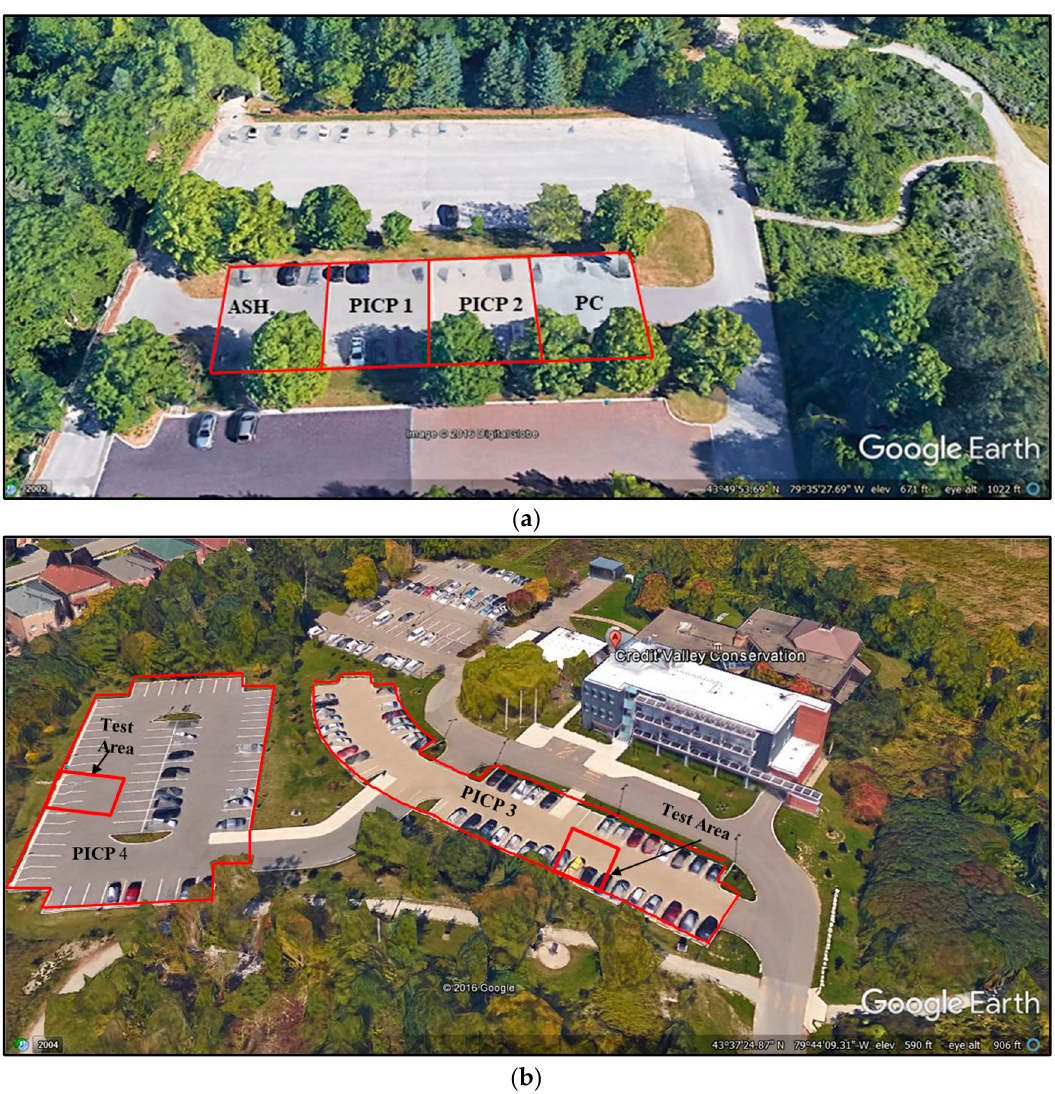
Figure 1. Field Sites ( a ) Parking lot at Toronto and Region Conservation Authority (TRCA), Vaughan ( b ) Credit Valley Conservation (CVC), Mississauga. Mapping Source: Google Earth 2016.